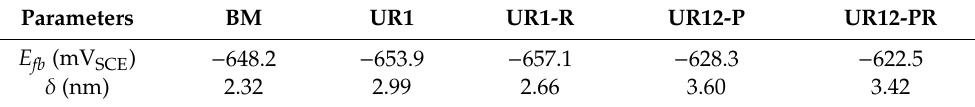
Figure 8. ( a ) Mott–Schottky plots of di ff erent samples after 15 min stabilization in the test solution and ( b ) the calculated acceptor densities. Table 5. Flat-band potential, E fb , and thickness, δ , of passive films formed on di ff erent samples.